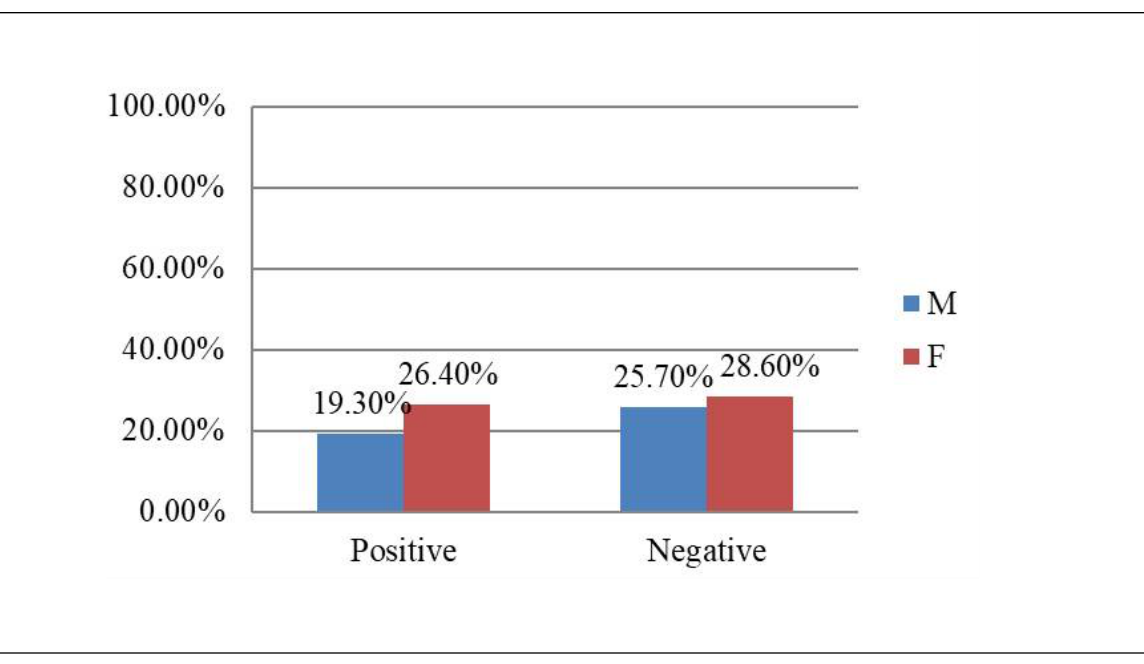
Figure 3: Prevalence of H. pylori according to the sex of the